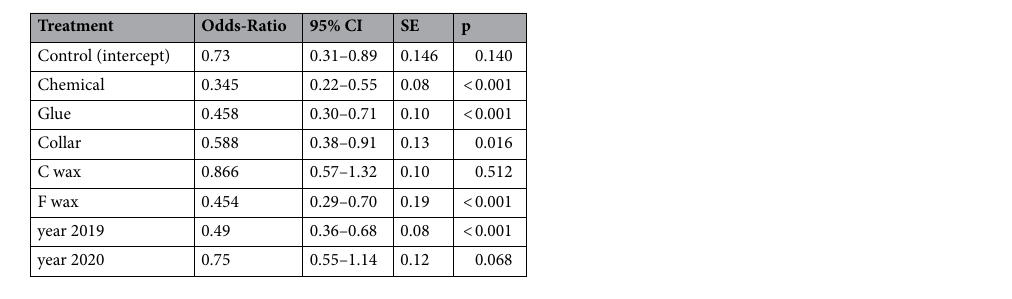
Table 6. Estimated parameters for the effect of treatments on the mortality of seedlings at the clear-cut site.